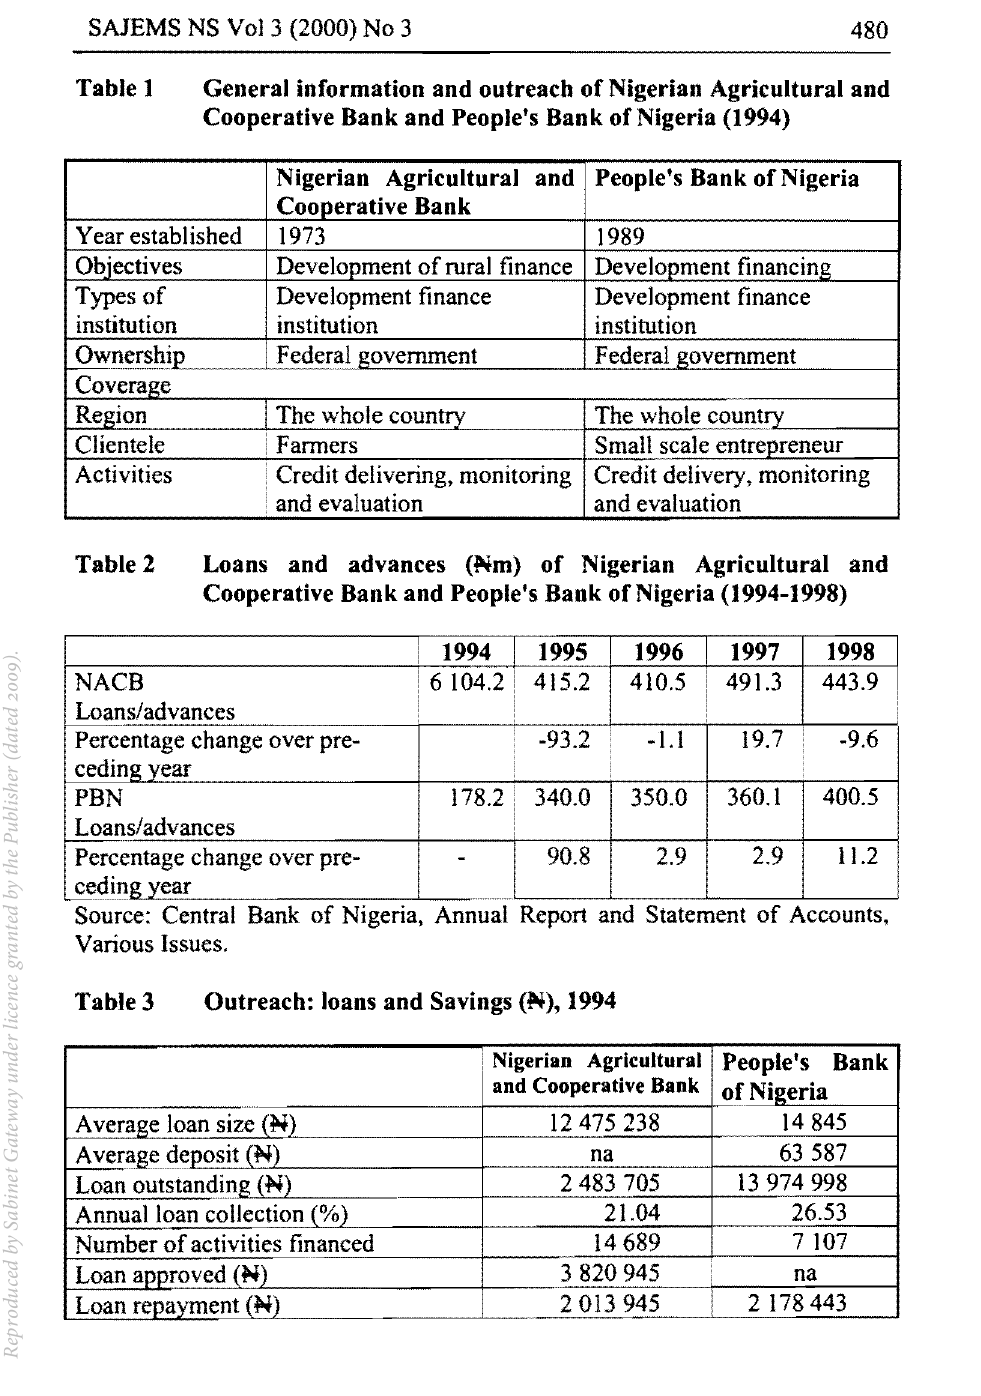
General information and outreach of Nigerian Agricultural and Cooperative Bank and People's Bank of Nigeria (1994)